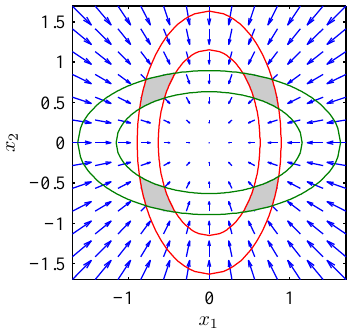
Figure 7: Illustration of an extended cell (shaded area). The extended cell is generated by intersecting slices from two slice-families. The red lines are the boundaries of the slice from the first slice-family; accordingly, the green lines are the boundaries of the slice from the second